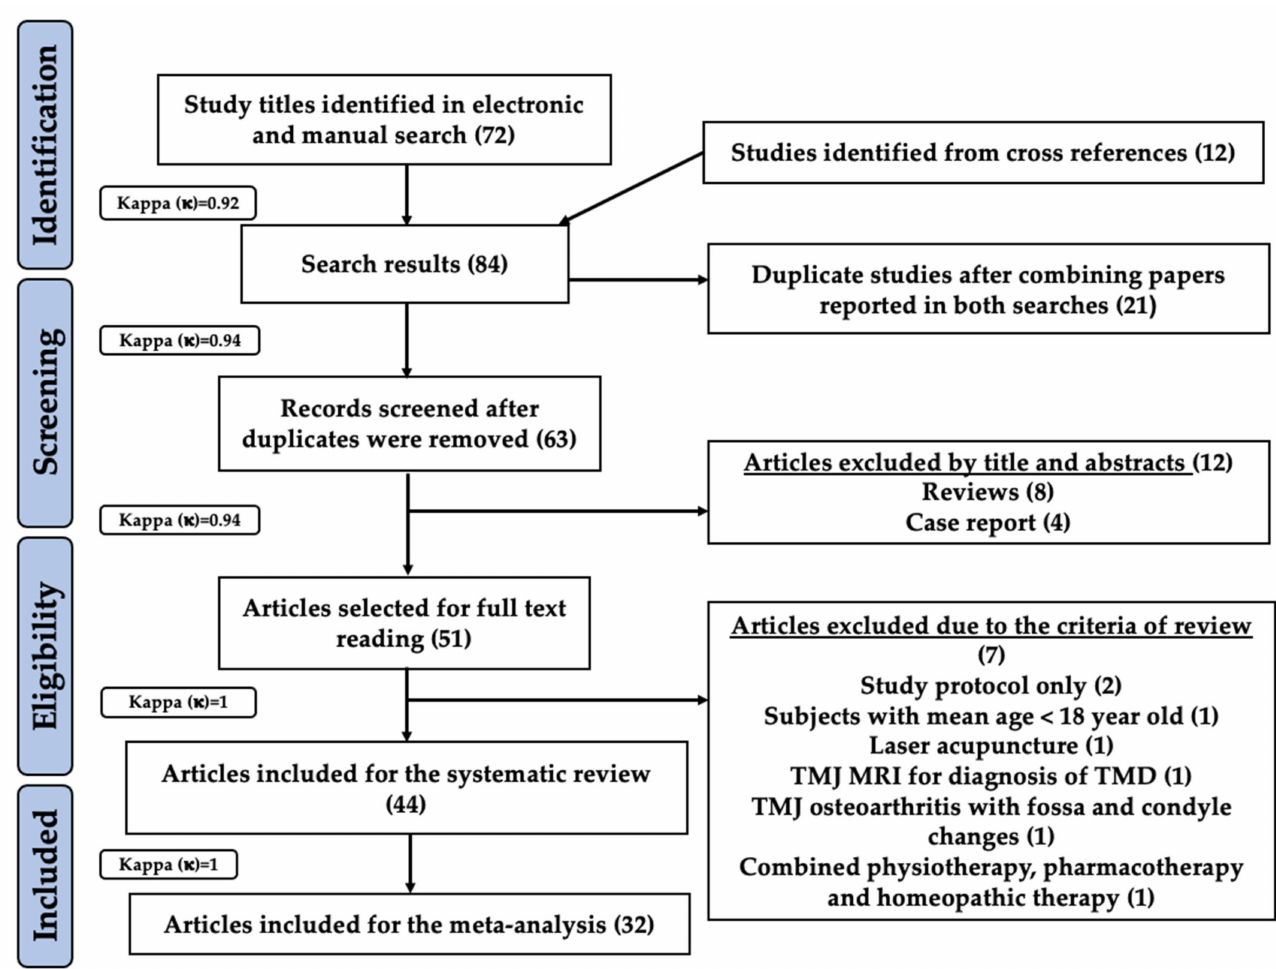
Figure 2. PRISMA flow-chart of selected criteria for the included articles